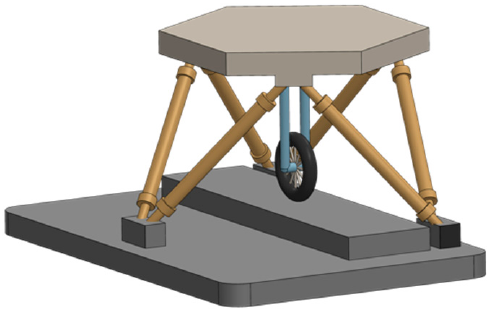
Figure 6. The schematic diagram of Gough’s parallel tire test mechanism.